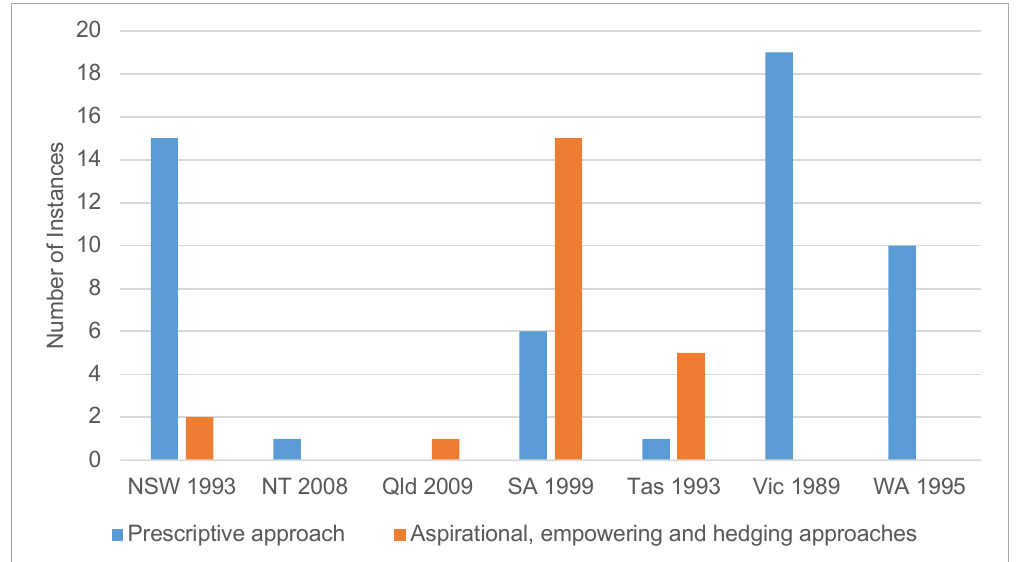
Figure 4: Public submission versus non-stipulated methods in core Australian Local Government Acts